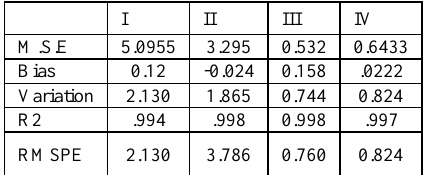
Table 1. Comparison criteria